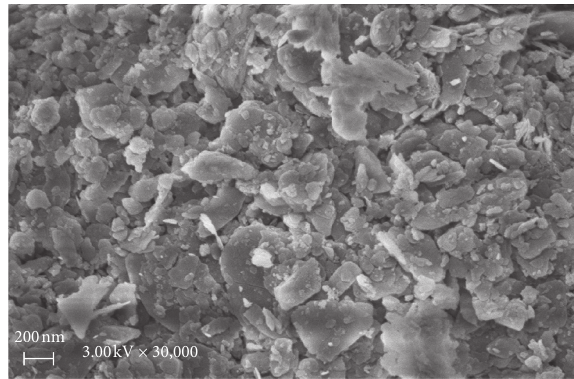
Figure 4: SEM image of red clay without calcium carbonate